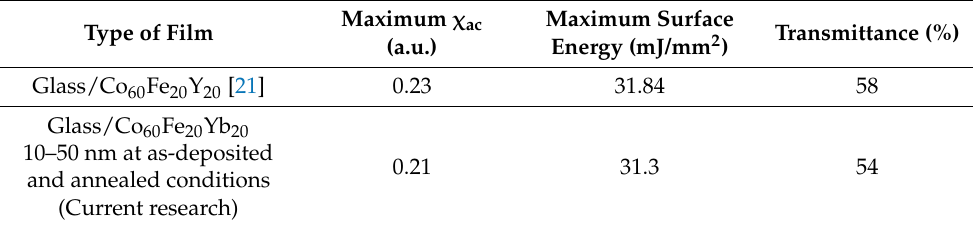
Table 1. Significant properties for Co 60 Fe 20 Y 20 and Co 60 Fe 20 Yb 20